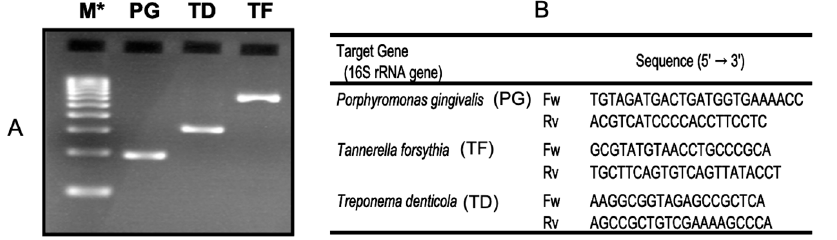
Figure 9. Electrochemical measurement of periodontal bacteria using PCR amplification [15]. ( A ) Electrophoresis of PCR-amplified genes encoding PG bactetium. Initial bacterial number(10 1 –10 5 ),